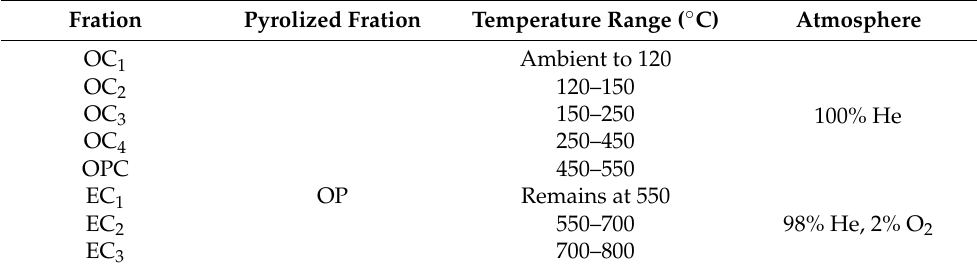
Table 2. Heating process and temperature in each stage of OC and